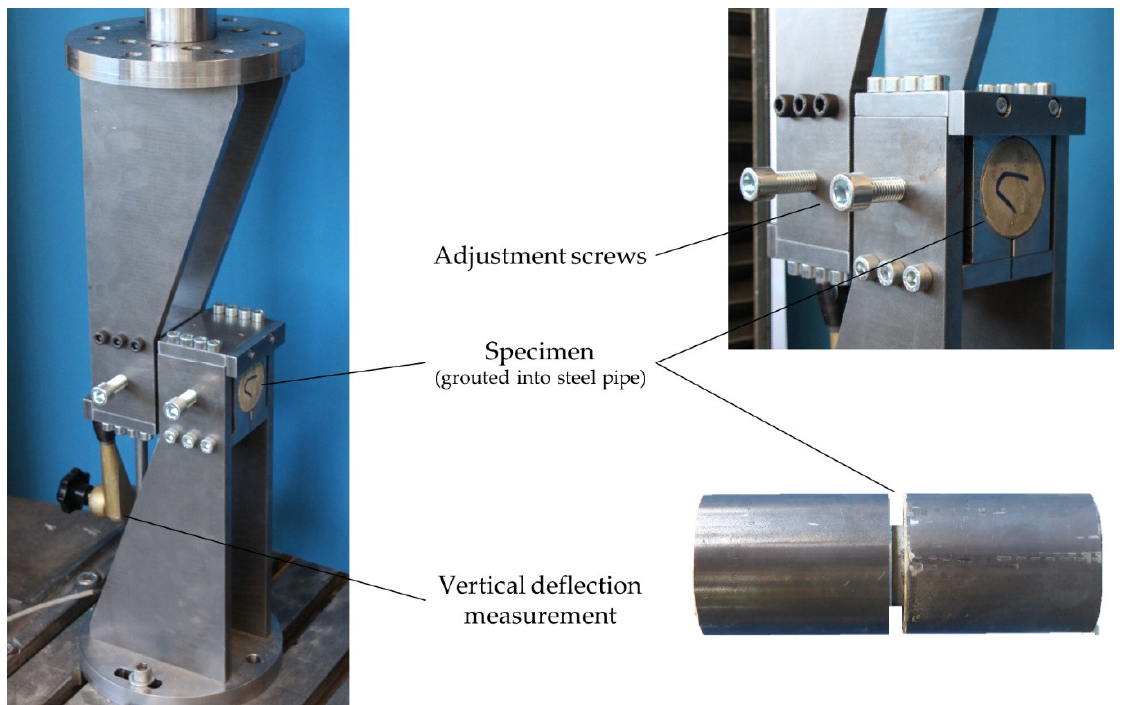
Figure 7. Proposed shear test setup for printed concrete specimen.